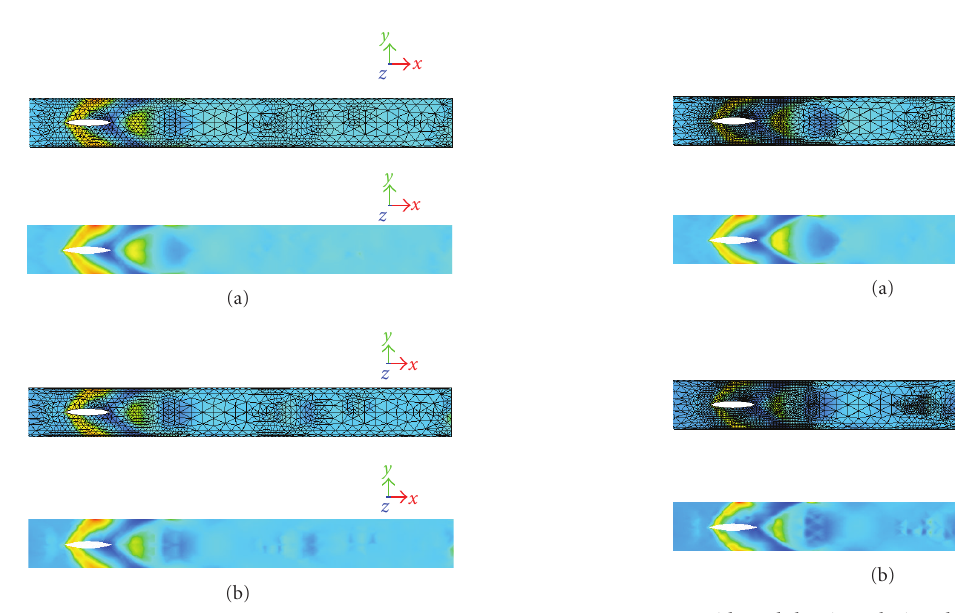
the diameter of the pipe is of 4 units. The initial coarse grid is uniform and contains 2486 nodes, 10683 tetrahedra, and 2384 triangular surface elements (Figure